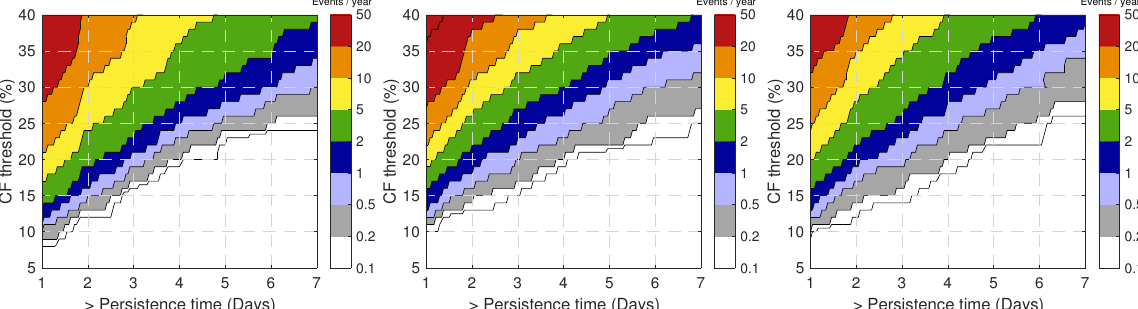
Figure 3. The frequency of Dunkelflaute events for Germany ( left panel), Norway ( middle panel), and the UK ( right panel) respectively, using different thresholds for capacity factor and time duration. The underlying data, spanning the years of 1985 to 2016, were generated by the Renewables.ninja